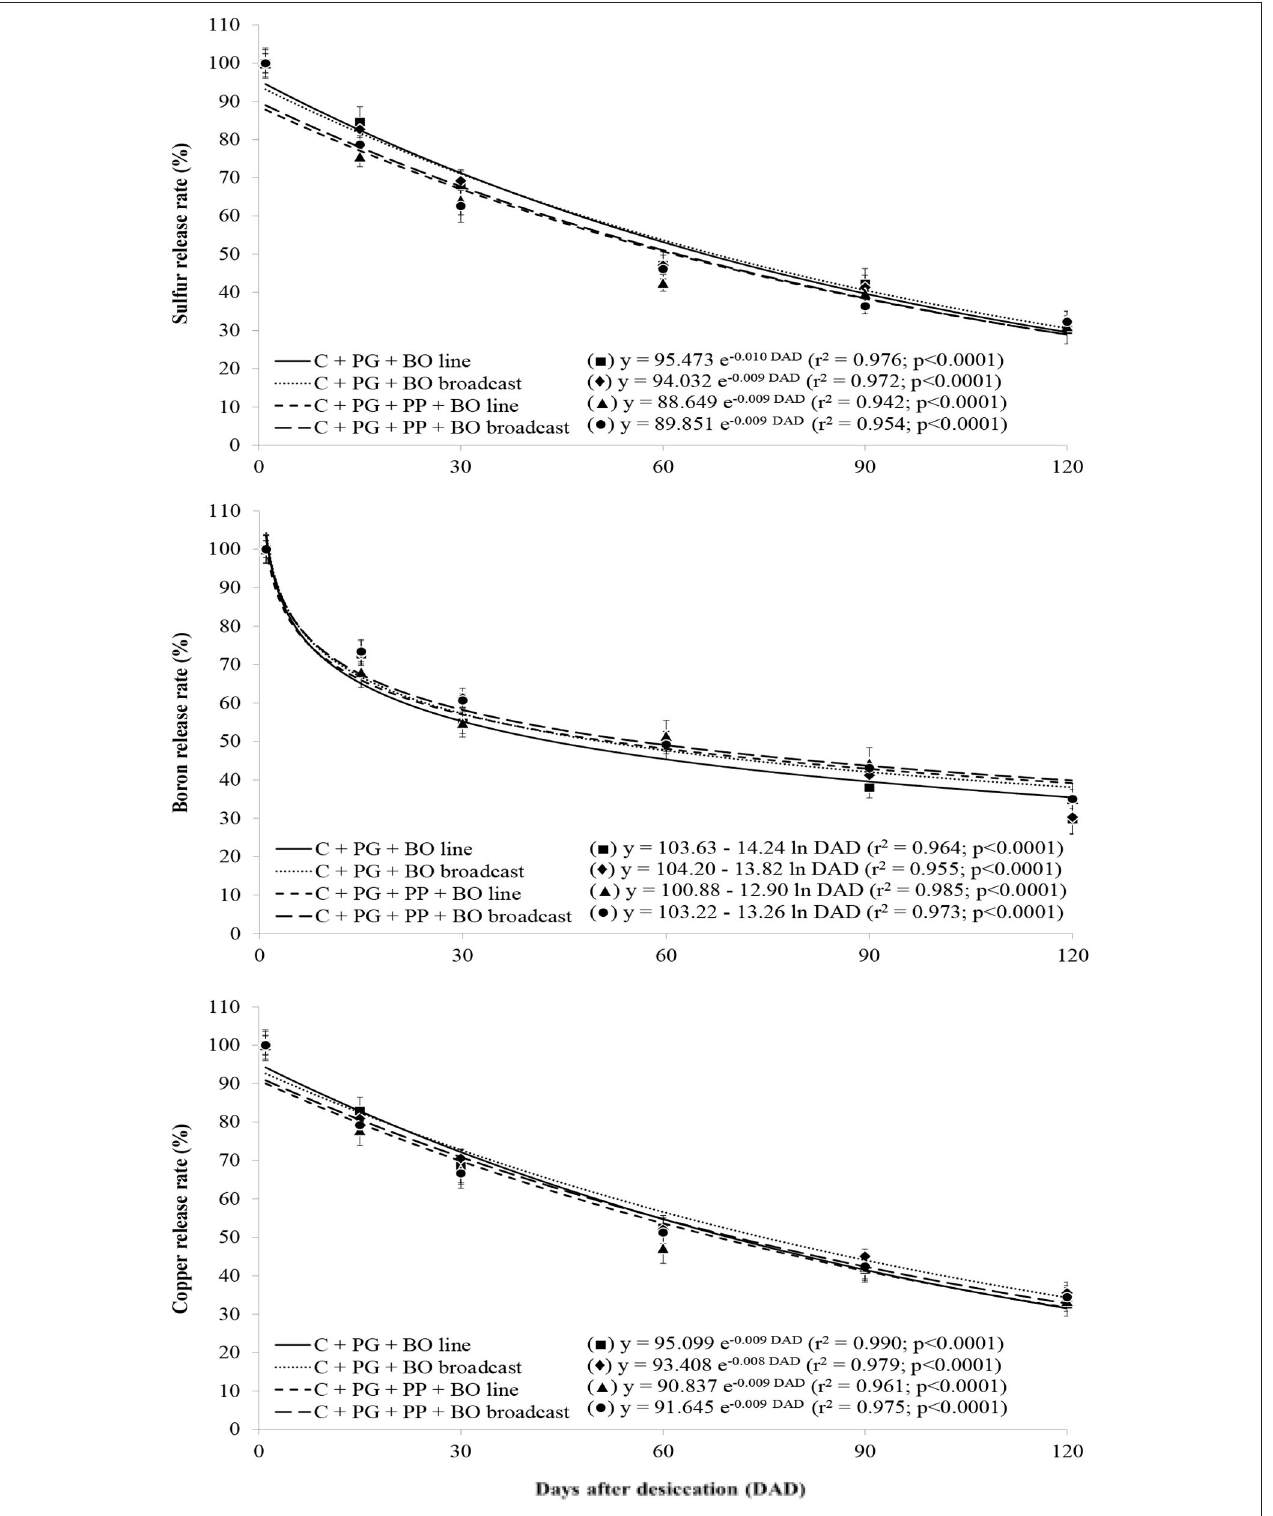
FIGURE 3 | Release rates of sulfur, boron, and copper in palisade grass (PG) intercropped with corn (C) and with corn and pigeon pea (PP) to silage with black oat (BO) oversown in lines and broadcast after grazing by lambs as a function of days after desiccation (mean of three growing seasons). Values are the mean of 12 replicates, and the associated error bar is ± 1 SE. Days after desiccation (DAD): days after pasture and weed desiccation with glyphosate herbicide, after grazing by lambs.